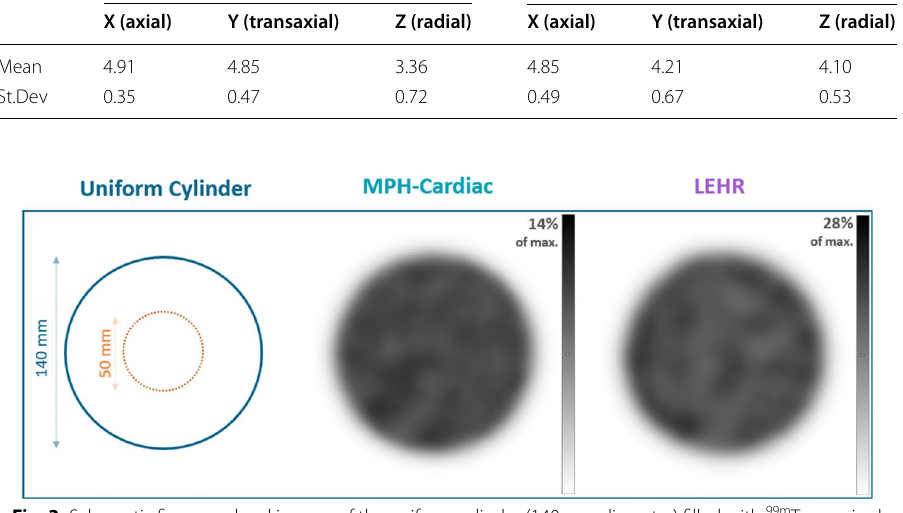
Fig. 3 Schematic figure and real images of the uniform cylinder (140 mm diameter) filled with 99m Tc acquired on the AnyScan SC LEHR system and AnyScan TRIO with MPH‑Cardiac collimator system. The upper limit of the inverted gray color bar compared to the maximum intensity in percentage is also indicated